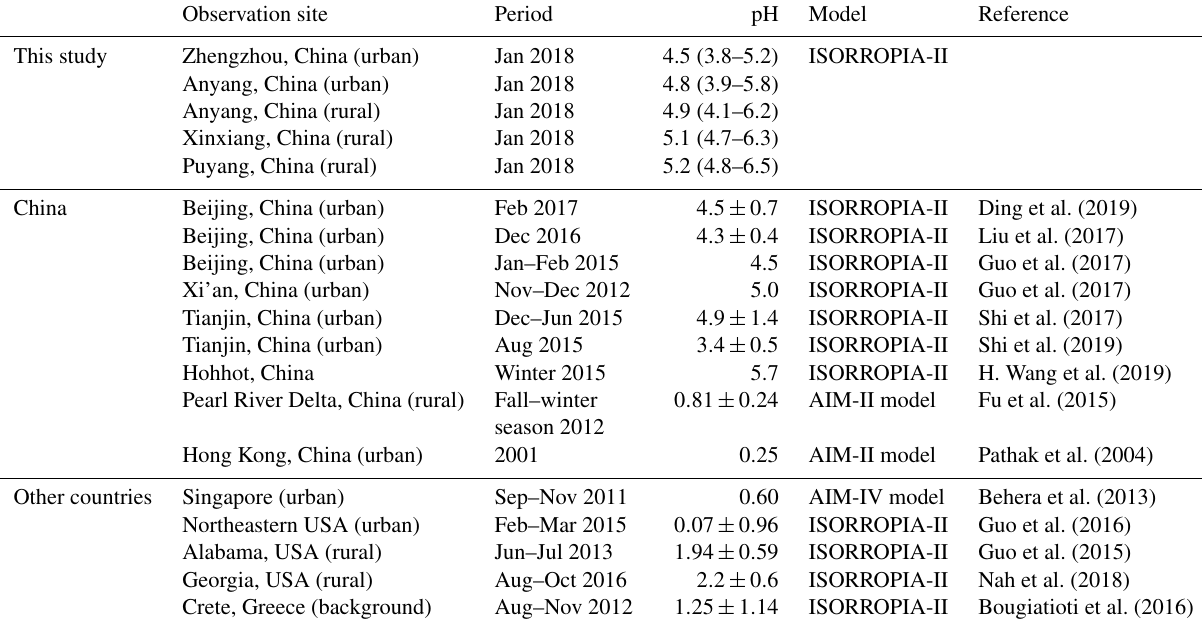
Table 2. Descriptions of the five sampling sites.